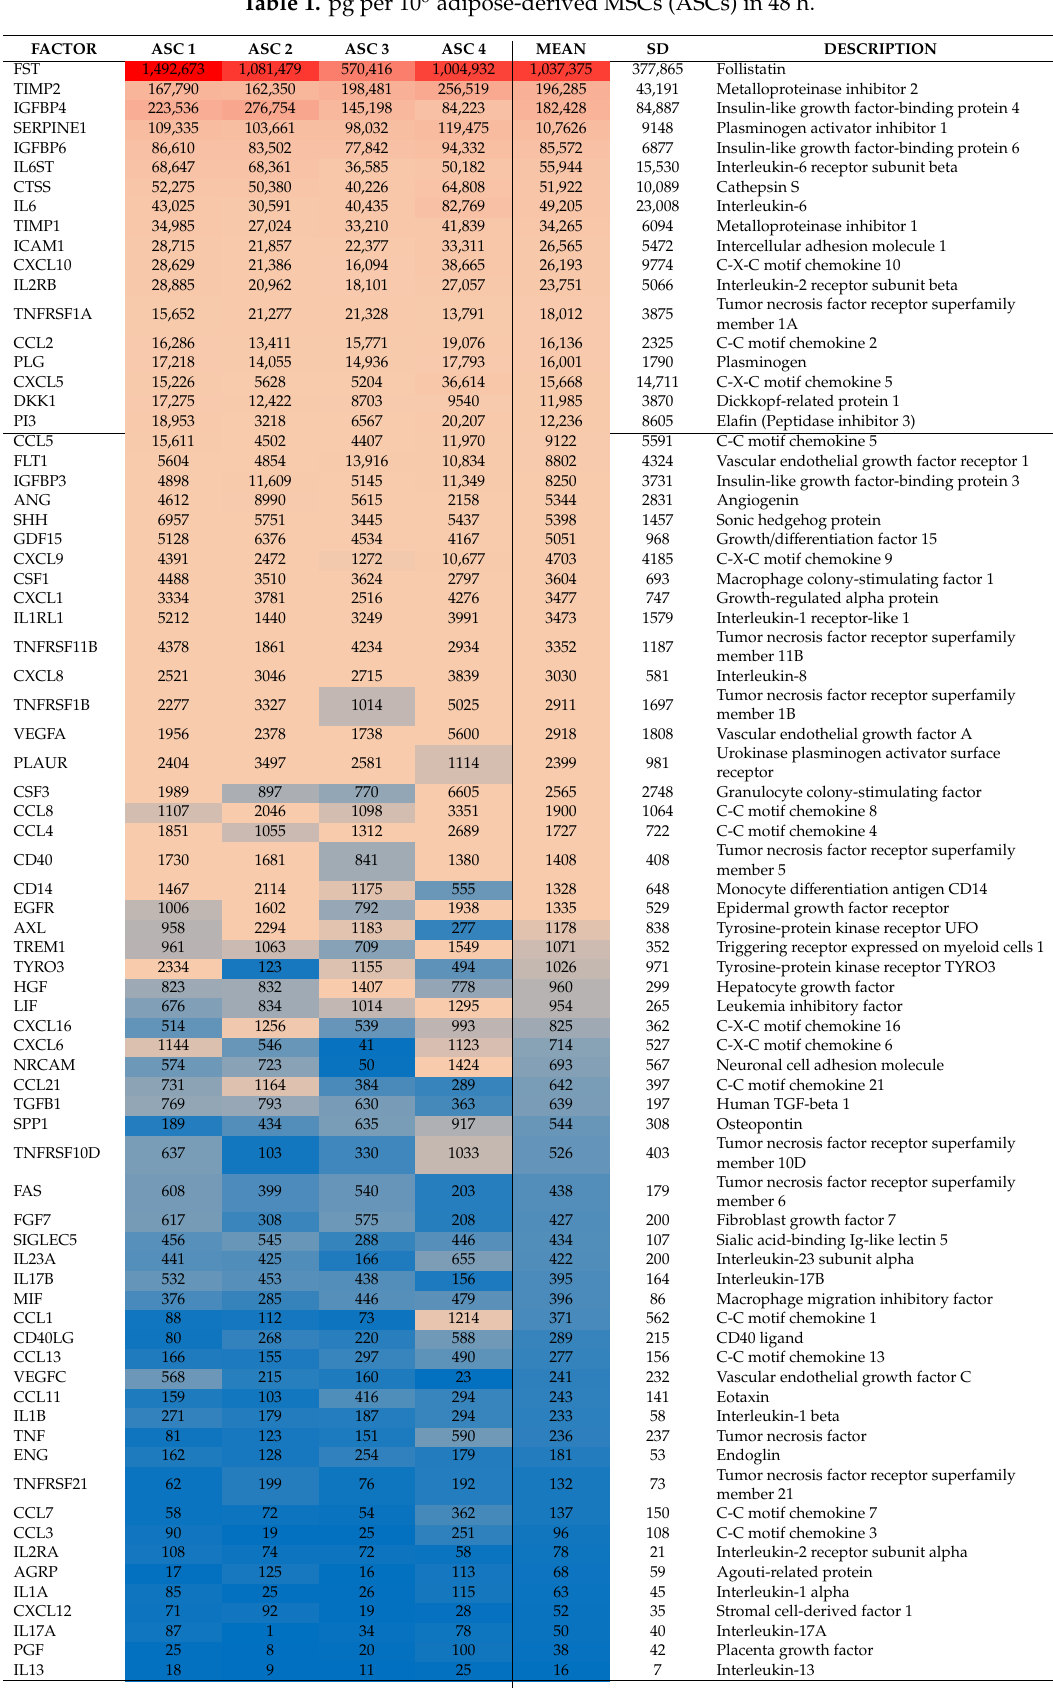
Table 1. pg per 10 6 adipose-derived MSCs (ASCs) in 48